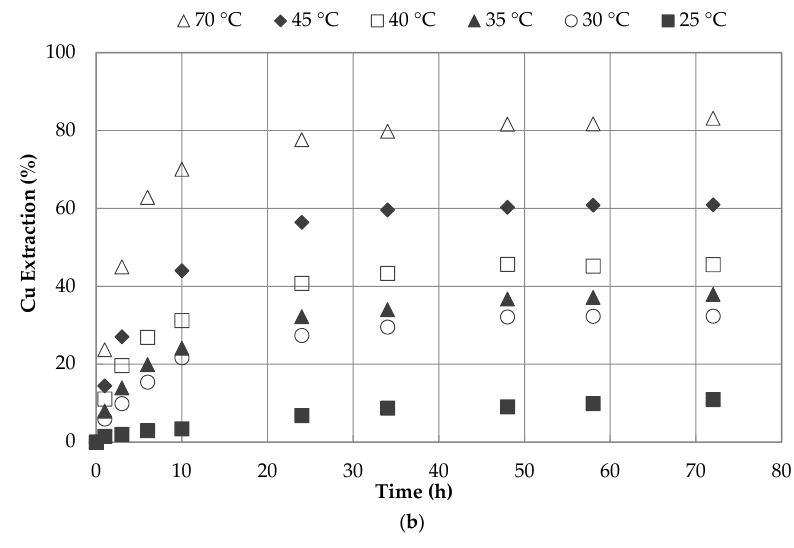
Figure 7. Effect of temperature on copper extraction using H 2 SO 4 (1 M), NaNO 3 (1 M), 3 days of leaching: ( a ) seawater and ( b ) water.